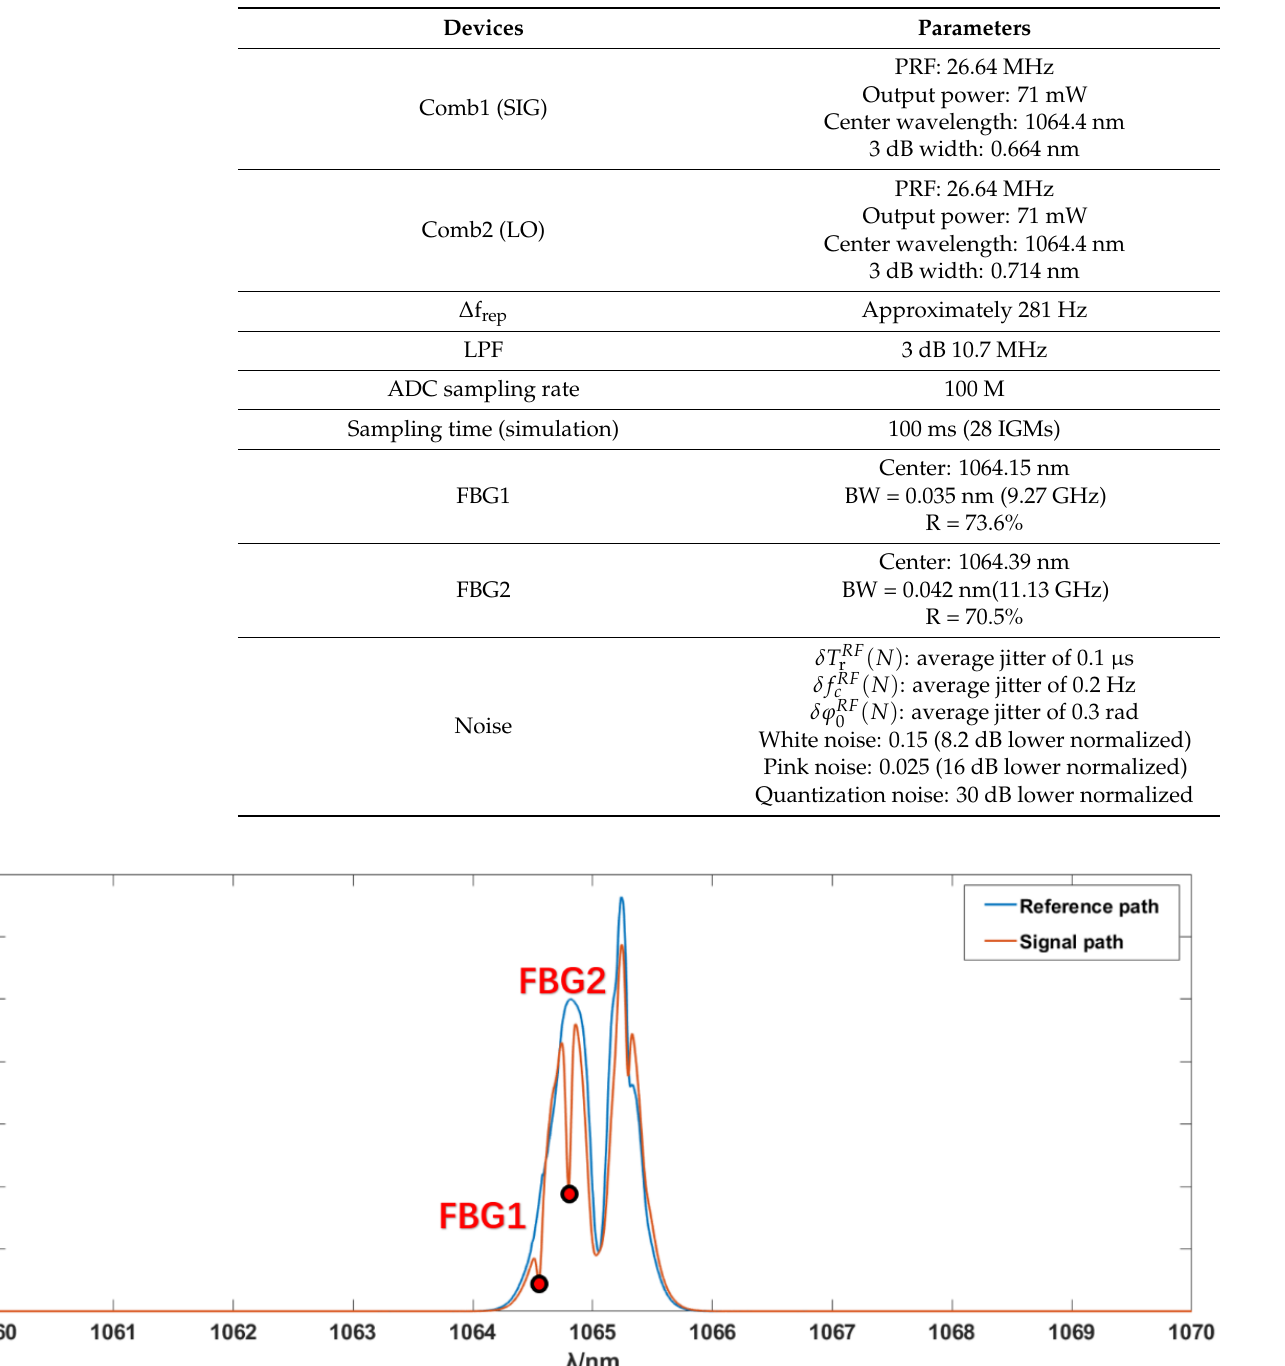
Table 1. Parameters of the DCS system.